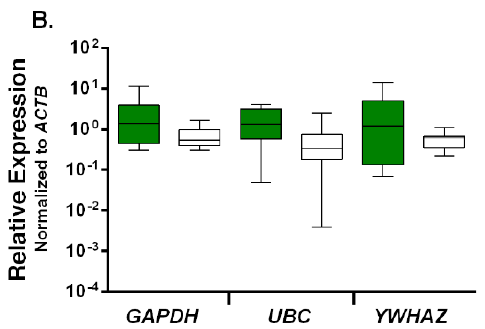
Figure 4. Comparison of the relative expression levels of candidate reference genes between the two groups. Colored and white boxes represent the autistic and control groups, respectively. The relative expression level for each gene was calculated by using either: ( A ) the GAPDH (glyceraldehyde-3-phosphate dehydrogenase); or ( B ) ACTB ( β -actin) gene as the reference. Statistical analysis comparing the expression levels are done with Mann-Whitney U test (two-tailed), and the data are presented as the mean and interquartile range, with vertical bars representing the total range ( B ). p -values: ( A ) ACTB ( p = 0.26), UBC ( p = 0.45), YWHAZ ( p = 0.82); and ( B ) GAPDH ( p = 0.26), UBC ( p = 0.03), YWHAZ ( p = 0.26).